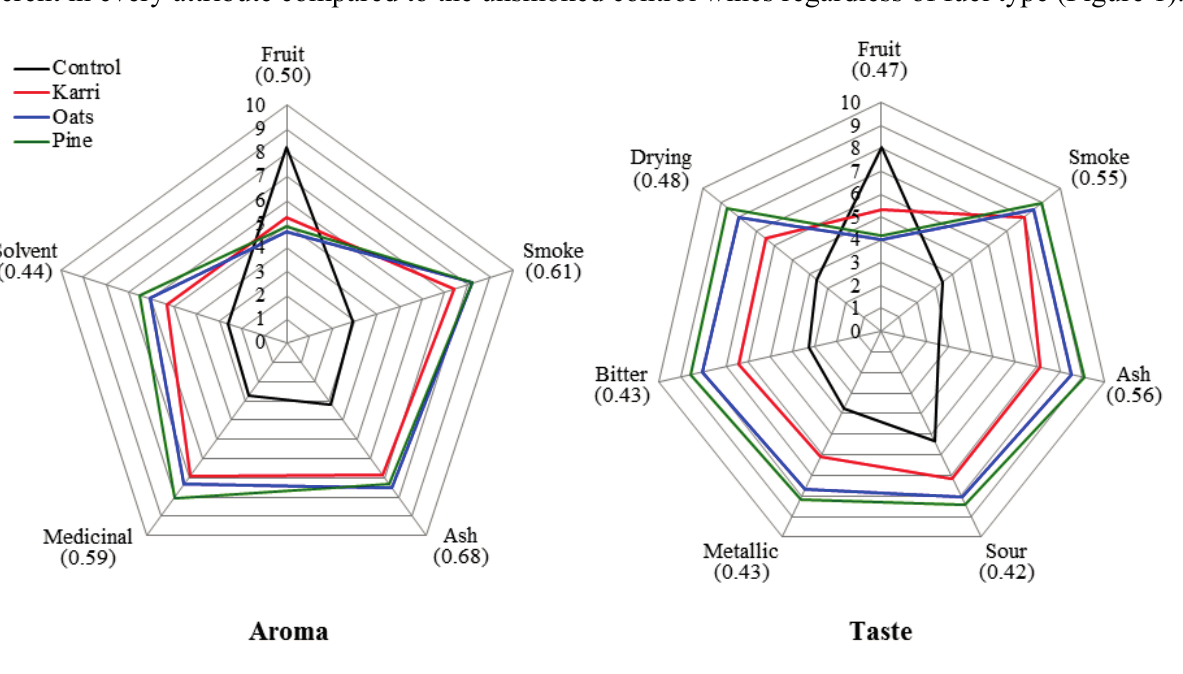
Figure 1. Influence of vegetation source of smoke on mean aroma ( left panel ) and taste ( right panel ) intensity ratings of Merlot wines. Numbers in parentheses following each descriptor are the least significant differences ( p =